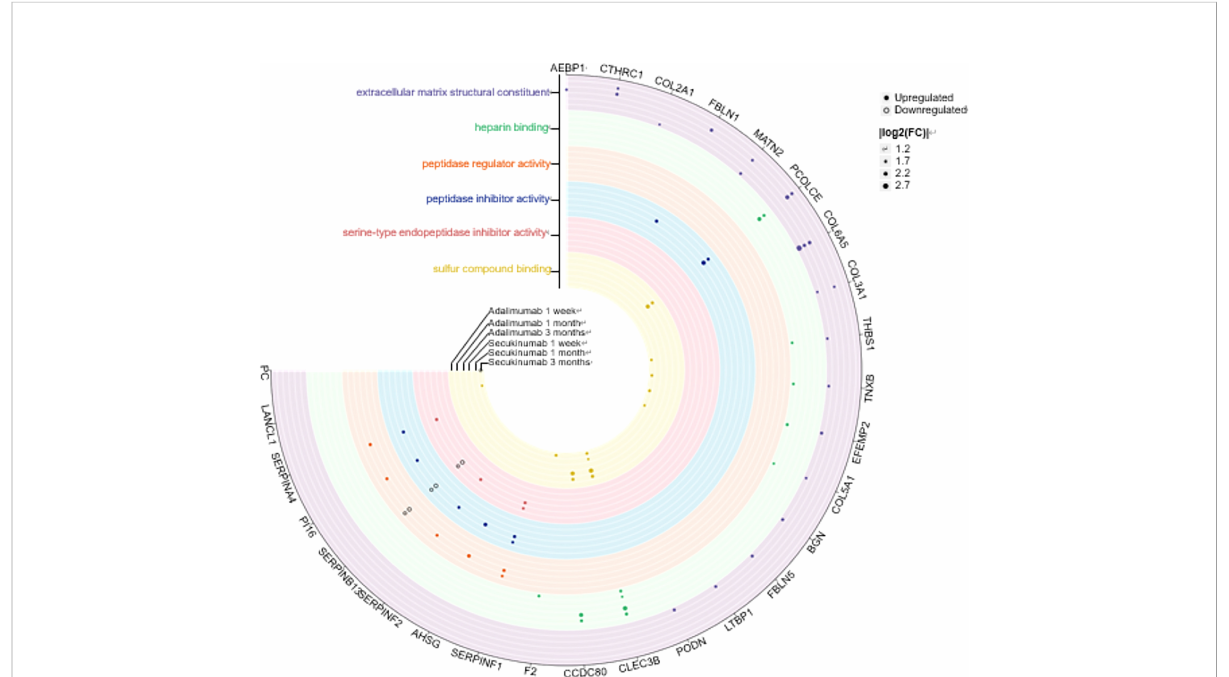
FIGURE 2 Six clusters of molecular functions in the two biological agent groups according to the GO enrichment analysis. The DEPs are labelled with circles (solid, upregulated proteins; hollow, downregulated proteins). Different colours represent different clusters. The size of the circle indicates |log 2 (FC)|. The cut-off was set at p value<0.05 and |log 2 (FC)| >log 2